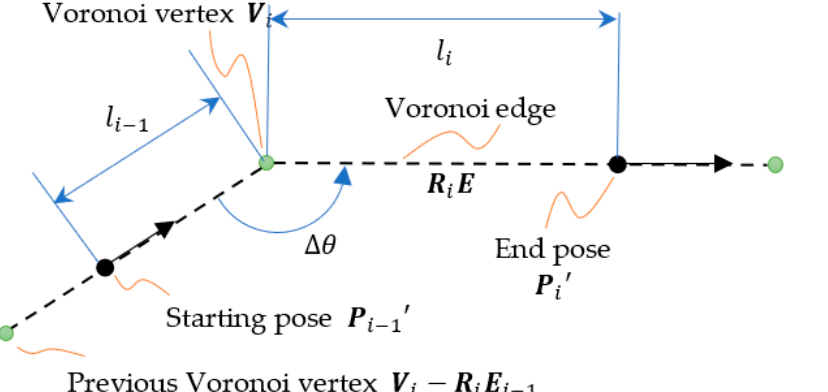
Figure 3. The Voronoi edges after rotation.